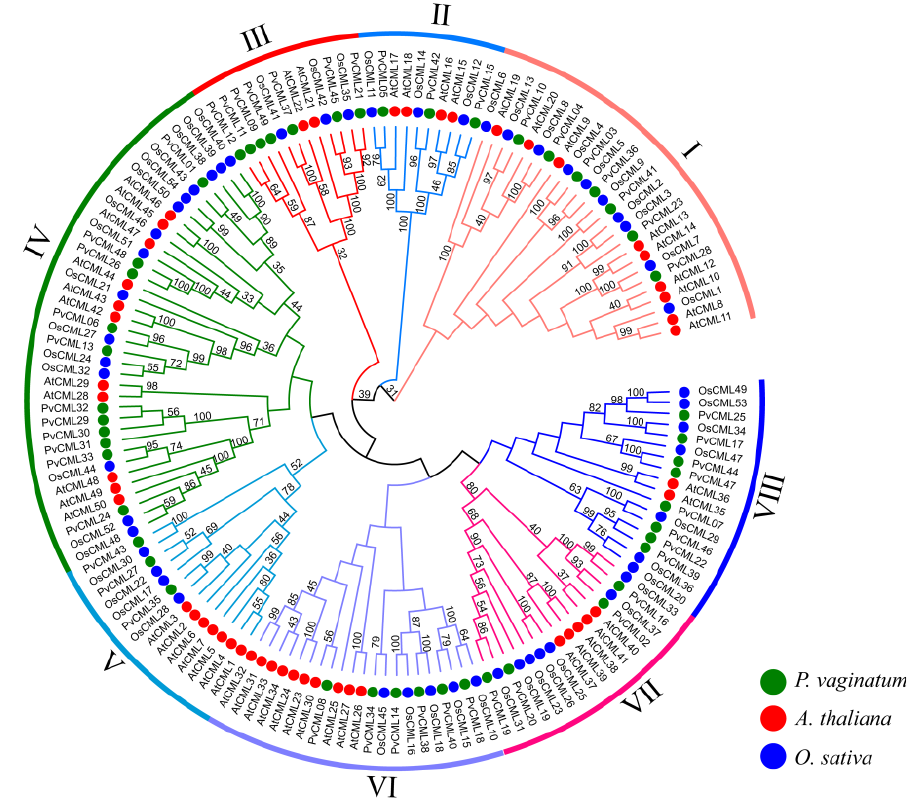
Figure 1. Phylogenetic relationship of calmodulin-like (CML) proteins in P. vaginatum (green), A. thaliana (red), and rice (blue). An unrooted tree was built using the NJ method in MEGA with 1000 bootstrap replications. The bootstrap values of each node lower than 30 were not shown.